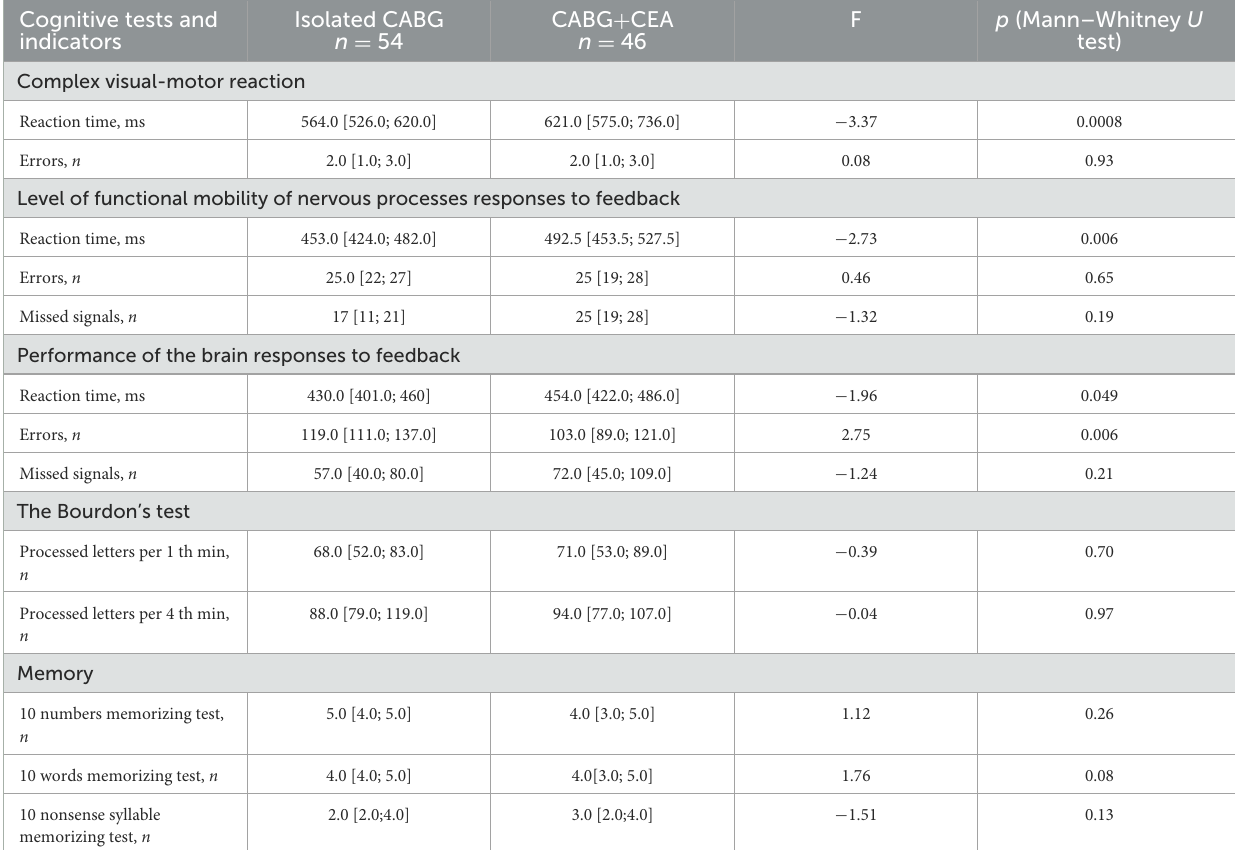
Isolated CABG n = 54